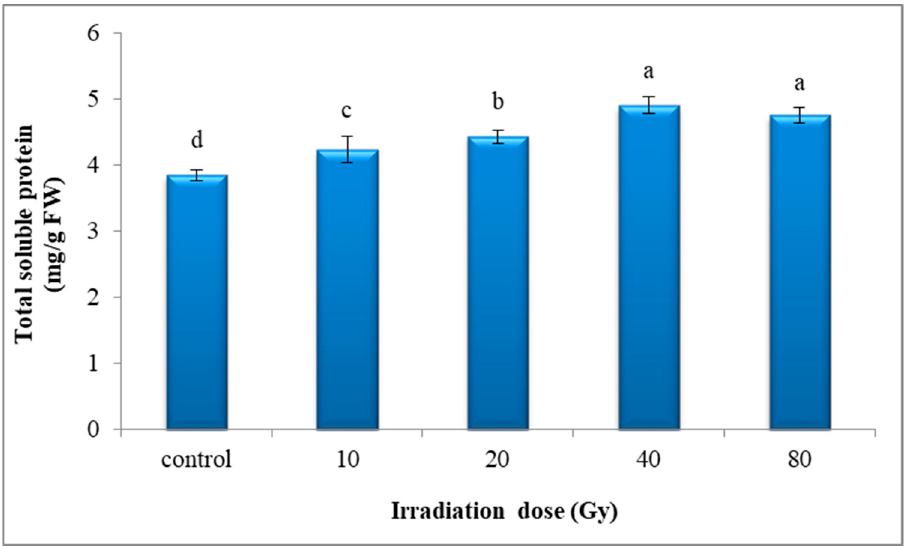
Figure 5. The content of total soluble proteins of red radish roots (mg/g FW) affected by different doses of gamma-rays. Findings are means ± standard deviations (n = 3). Different letters point to significant variations at p ≤ 0.05, and bars indicate standard deviations.